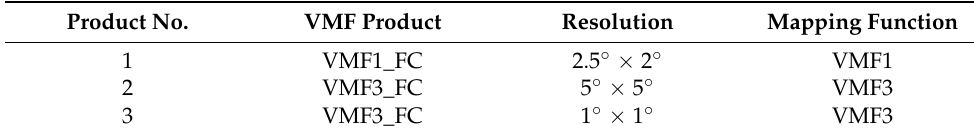
Table 2. Three VMF forecasting data were tested in this research. Product No. VMF Product